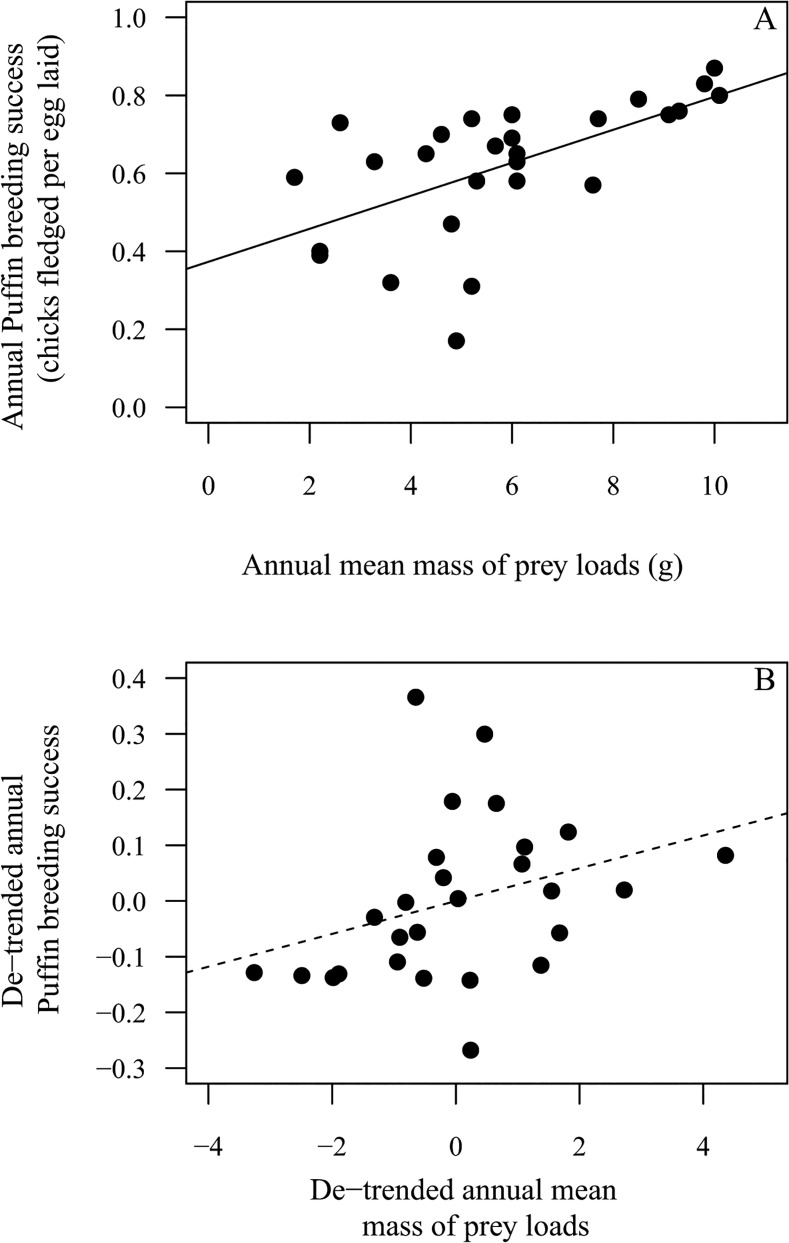
Relationships between Atlantic Puffin breeding success and annual mean mass of fish loads delivered to chicks.A. Values of annual adult Atlantic Puffin breeding success and annual mean mass of fish loads delivered to chicks in the same year during 1987 to 2013 plotted against each other without de-trending and B. plot of de-trended residuals. Lines represent fitted linear regressions (solid line = significant positive correlation, stippled line = weak positive correlation, non-significant).